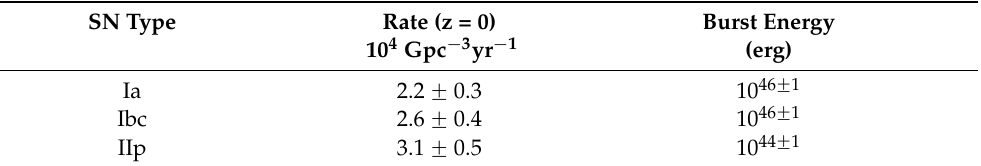
Table 3. Parameters to estimate lethal number of SNe: cosmic rate and burst energy ( E SN ) for each SN type, as reported in [34,57,58,114–116].